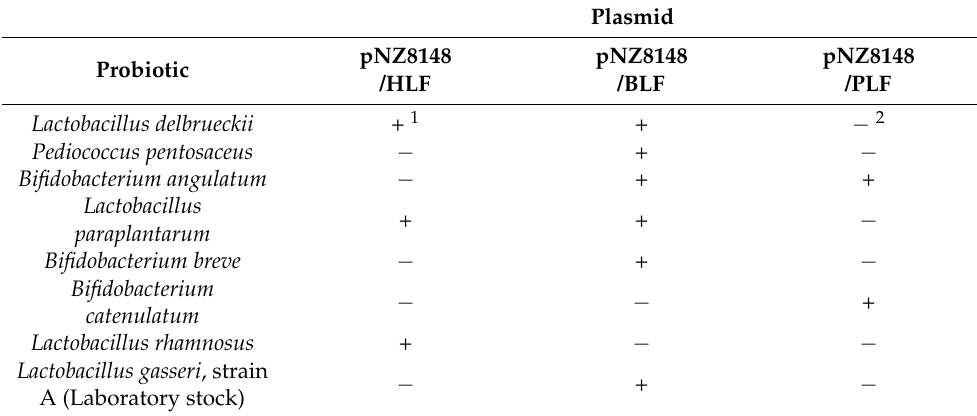
Figure 1. Analysis of DNA construct of pNZ-8148 and lactoferrin genes. ( a ) Vector mapping and multicloning sites. * indicates the used restriction sites in this work. ( b ) Visualization of plasmid vector and target lactoferrin genes using electrophoresis. Lane 1: marker; lane 2: pNZ8148; lane 3 to 6: amplified human lactoferrin genes; lane 7 to 10: amplified bovine lactoferrin genes; lane 11 to 14: amplified porcine lactoferrin genes. Table 1. Selection of probiotic strains with transformed vectors as the stable